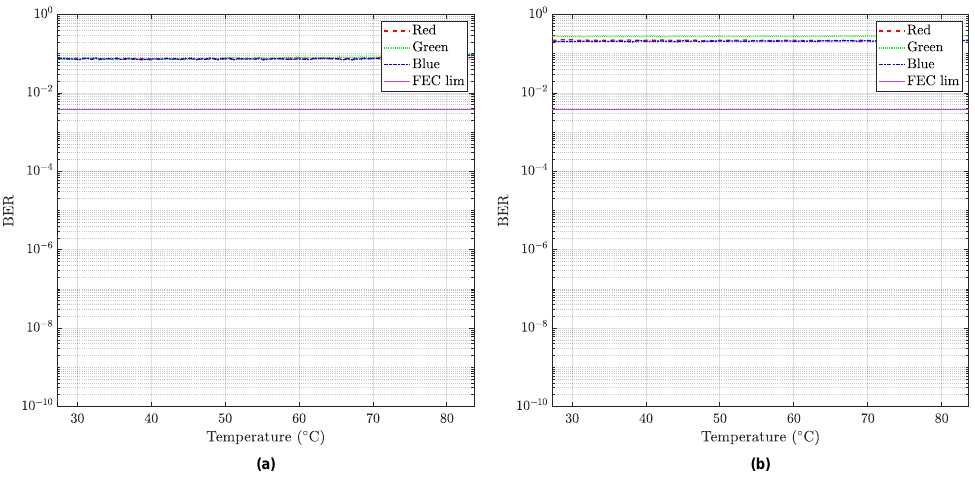
Figure 18. BER at different temperatures, compensating the channel using the CSI corresponding to 60°C and with a low SNR value (10 dB). ( a ) Sony IMX249 and ( b ) Foveon X3. Dashed line, dotted line, and dash-dot line correspond to red, green, and blue,